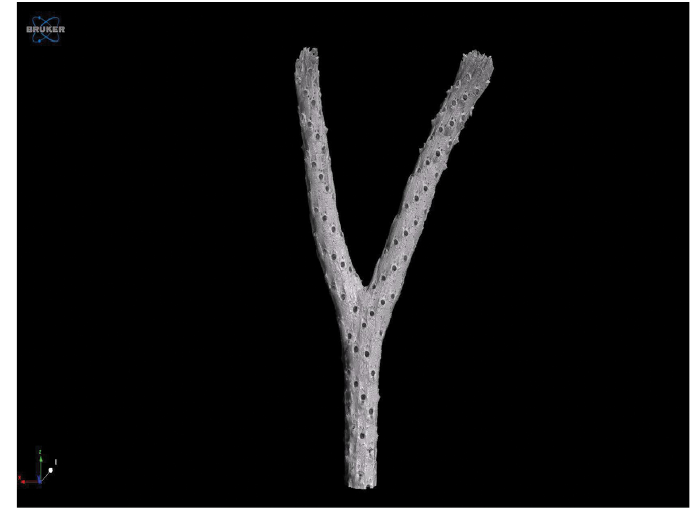
Figure 14. Video of the 3D-model of Eminooecia carsonae (Rogick, 1957) (MNA 8408). Height and width of the colony are respectively ~21.7 mm and ~1.8